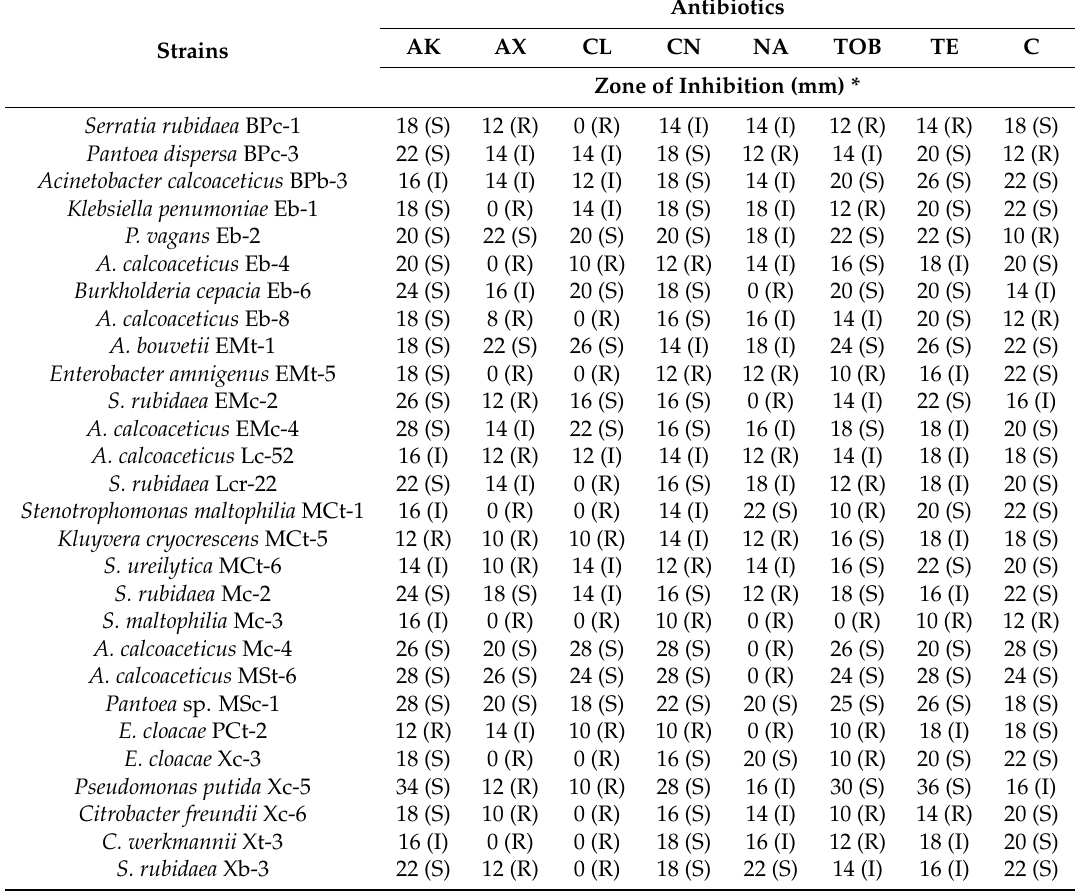
Table 5. Antibiotic susceptibility pattern of different Gram-negative bacterial isolates. For analysis, three set of plates for each strain or antibiotic were incubated at 37 ◦ C for 24